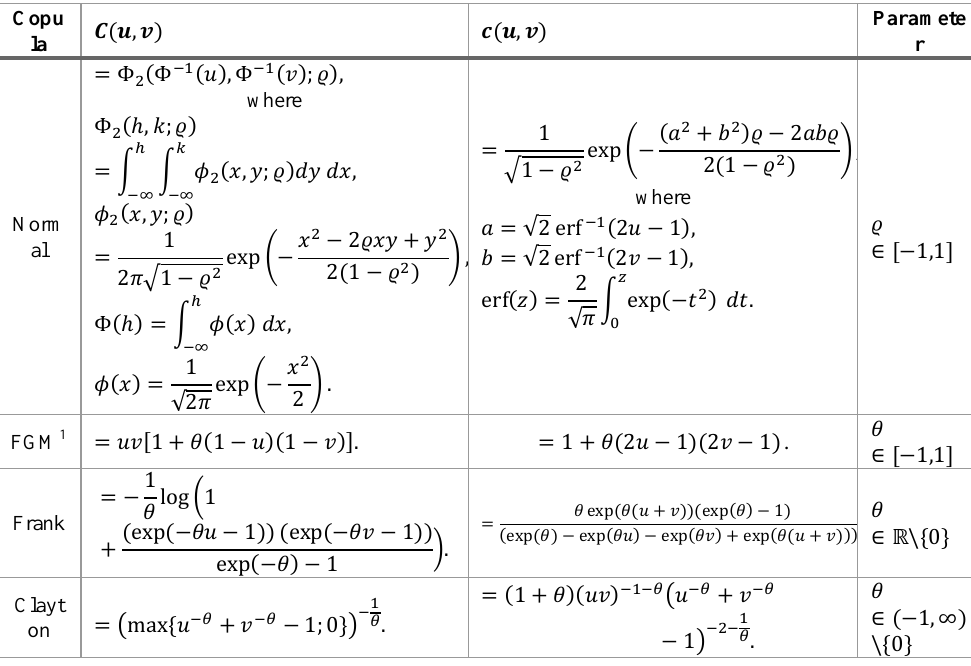
Table 6. Some two-variable copulas with their